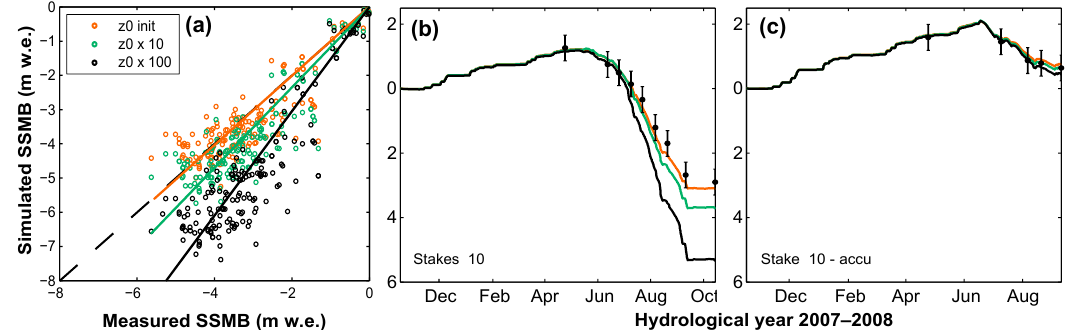
Figure 9. (a) Correlations between simulated and measured summer SMBs at each measurement point over the 2006–2010 period, using different roughness lengths. Surface mass balance evolution at one stake in the ablation area (b) and at one stake in accumulation area (c) over the hydrological year 2007–2008. SMB was simulated using different roughness length values for snow and ice – z 0ice = 1mm and z 0snow = 0 . 1mm (orange), z 0ice = 10mm and z 0snow = 1mm (green), and z 0ice = 100mm and z 0snow = 10mm (black).